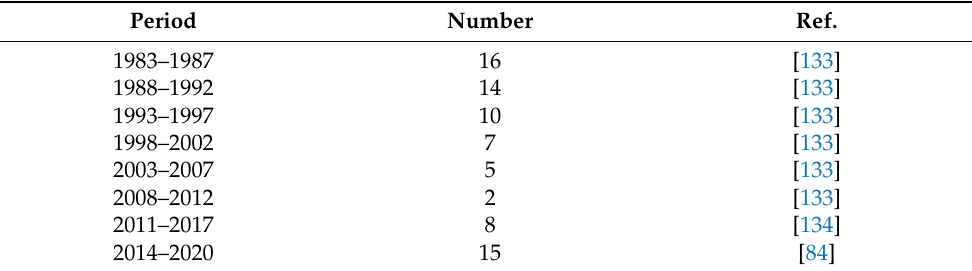
Table 1. New antibiotic drugs approved by FDA in the period 1983–2012